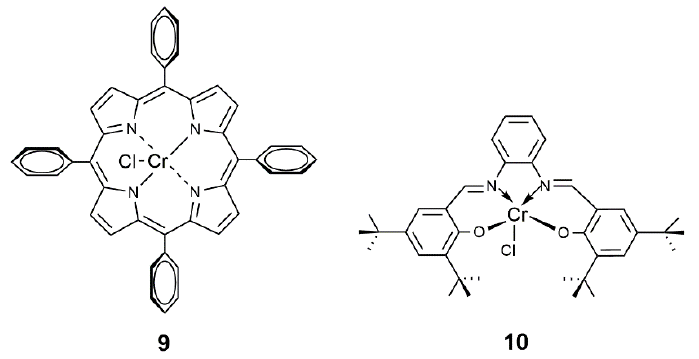
Figure 5. Catalysts 9 and 10 used by Duchateu in the terpolymerization of CO 2 , CHO and dicarboxylic acid anhydrides (SA, CPrA, CPA, PA) [28].